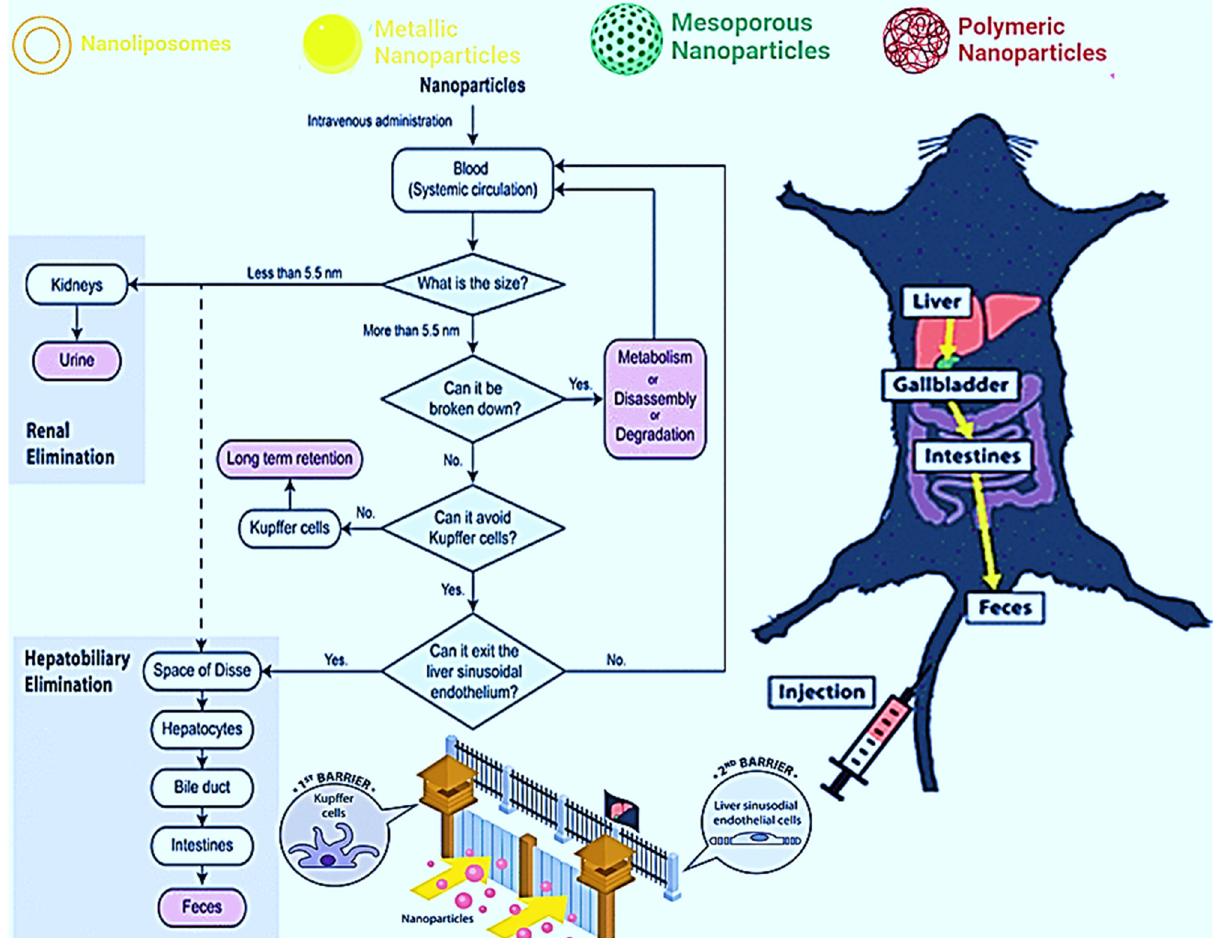
Figure 2. Schematization of the intravenous administration of NPs and the possible mechanisms of elimination: (1) liver, (2) gallbladder, (3) intestines, and finally (4) feces. Reprinted/adapted with permission from Poon et al. [163]. Copyright 2019, ACS Chemical Society.